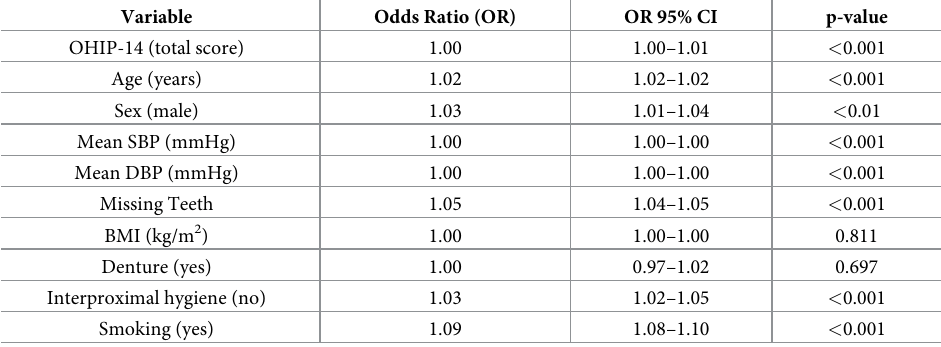
Table 3. Multiple logistic regression on the association between radiographically screened periodontitis and OHIP-14 (n =